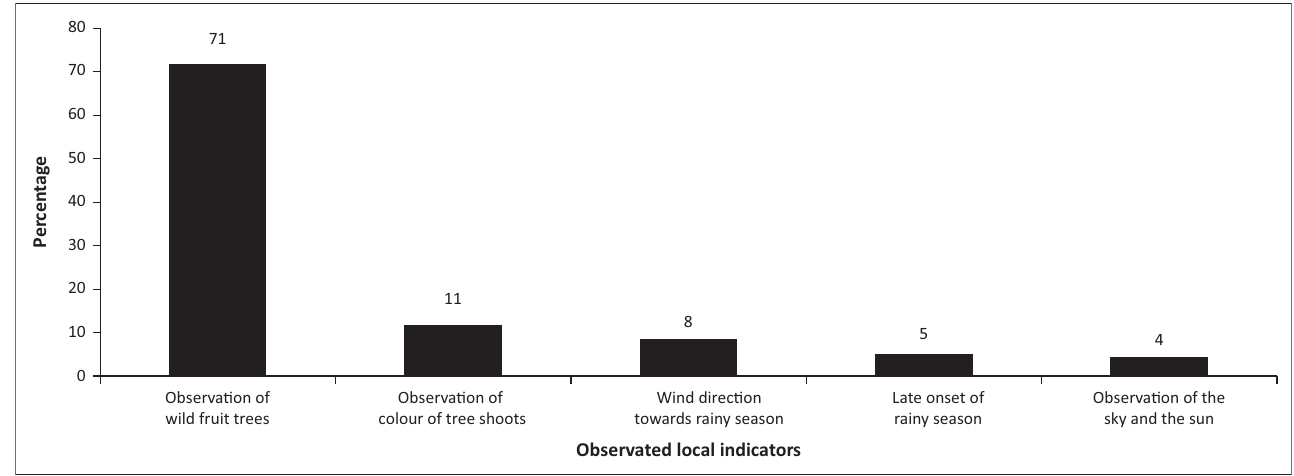
FIGURE 3: Local indicators for seasonal weather forecasting and drought prediction ( n =